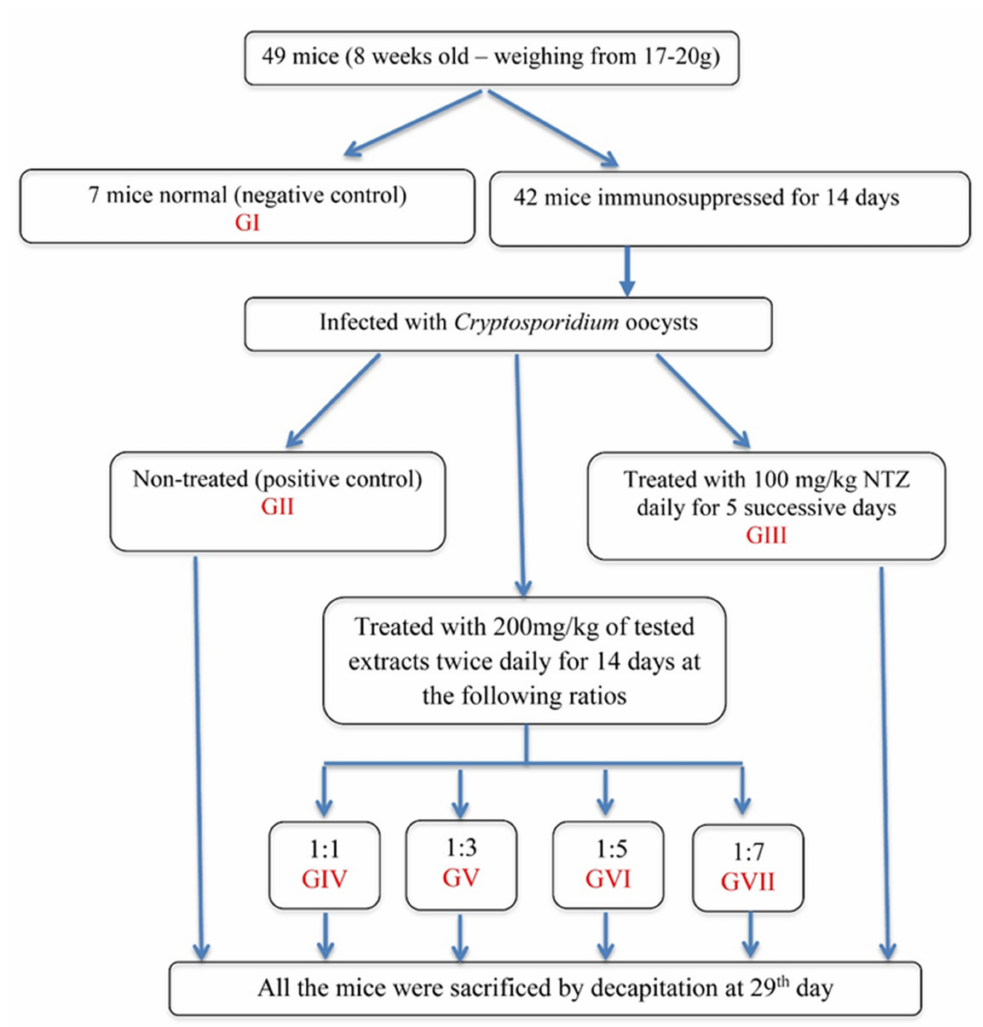
Figure 1. Flow chart of experimental